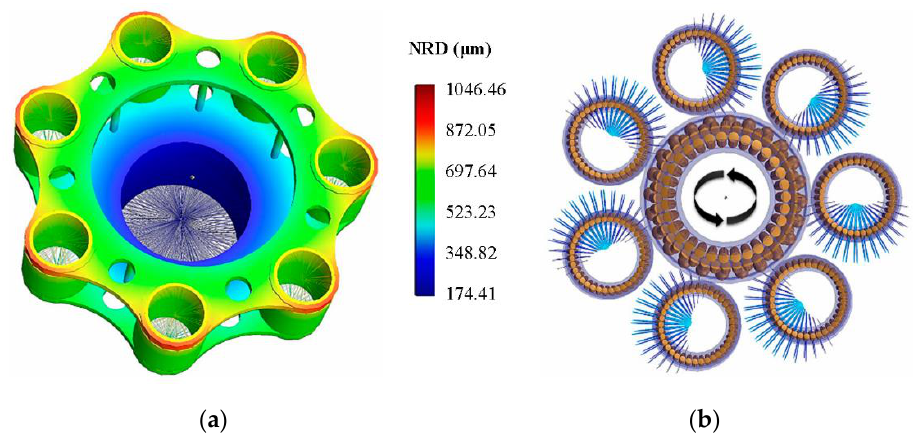
Figure 7. Mechanical analysis result: ( a ) displacement nephogram of planet carrier; ( b ) roller force diagram of DRTRB.